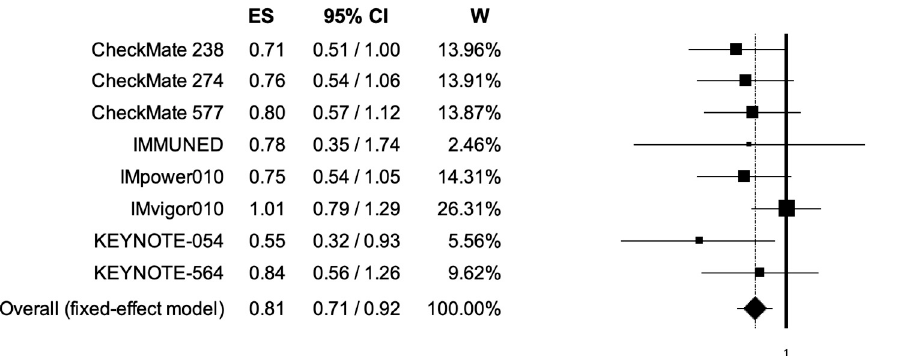
Figure 7. Forest plot of comparison between adjuvant PD-1 and PD-L1 inhibitors versus control (placebo/ipilimumab/observation/best supportive care) in cancer patients; the outcome of interest was relapse-free survival (RFS) in elderly patients. Abbreviations: CI: confidence interval; ES: effect size; and W: weight.